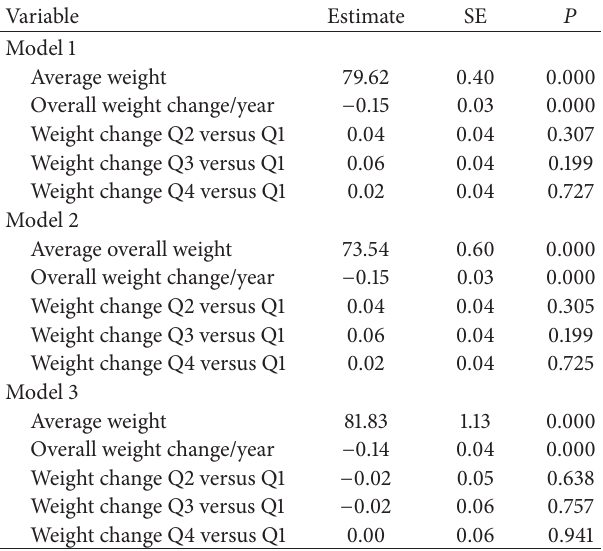
Table 4: Results of the mixed effects model examining the relation- ship between anxiety quartiles and weight change